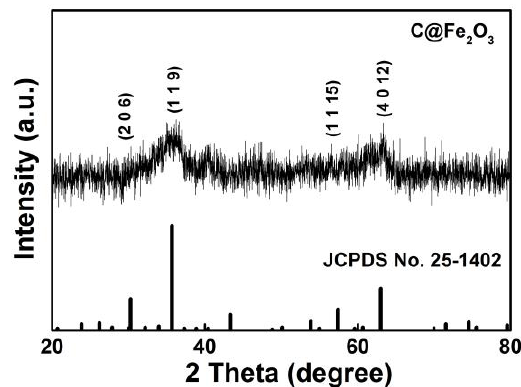
Figure 1. X-ray diffractometer (XRD) patterns of the C@Fe 2 O 3 composite.